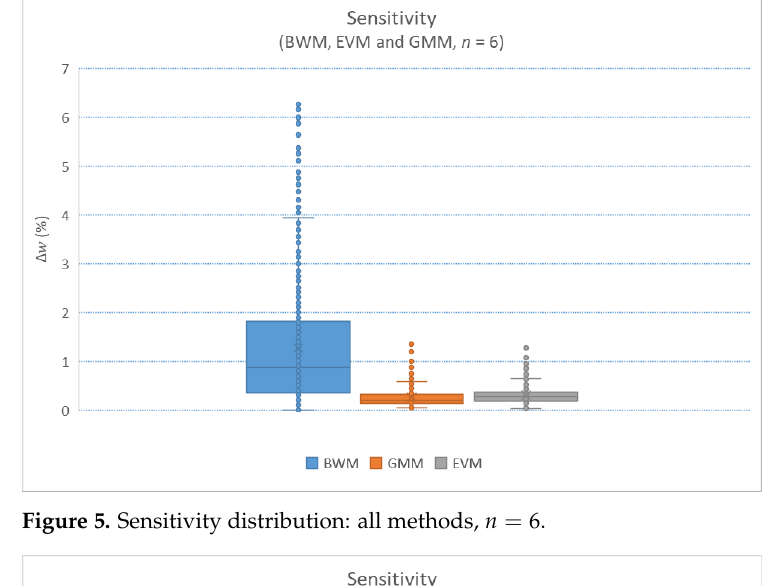
Figure 5. Sensitivity distribution: all methods, n = 6.